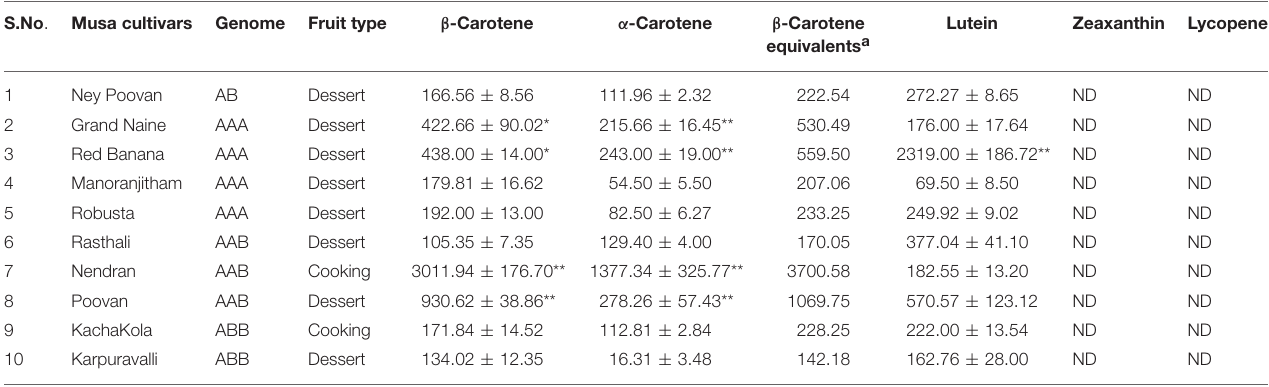
TABLE 1 | Carotenoids ( µ g/100g DW) in ripe fruit-pulp of Indian banana cultivars. S.No . Musa cultivars Genome Fruit